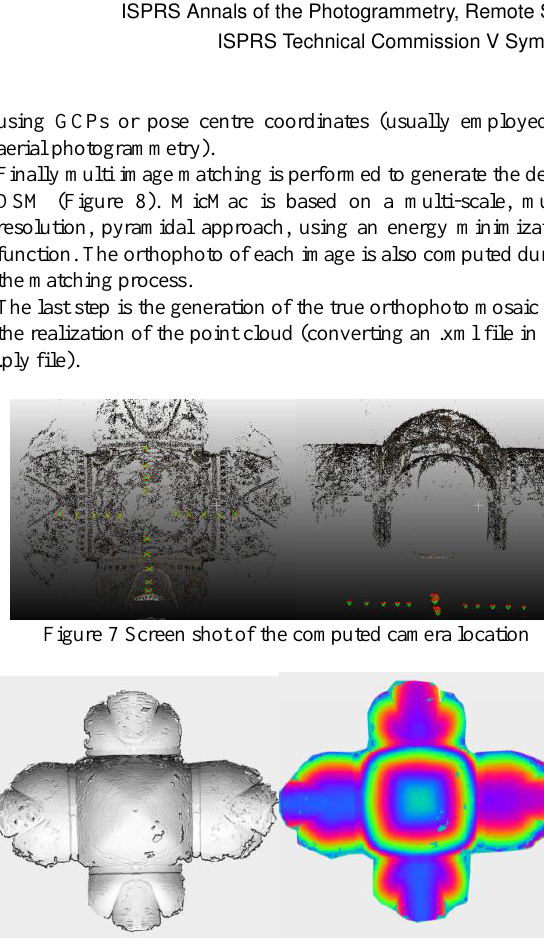
Figure 8 Shaded view (left) and 8bit colored DSM (right) achieved using MicMac